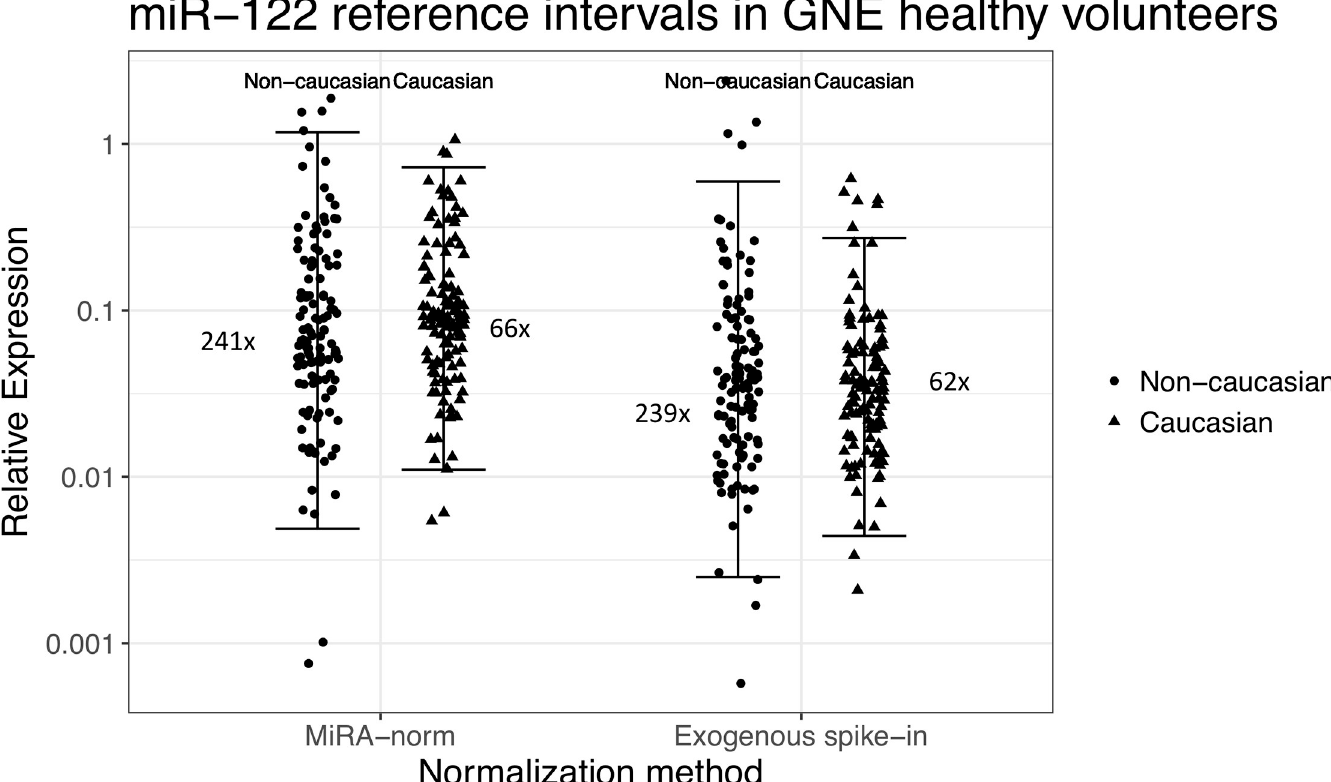
Fig 4. The 95% confidence reference ranges of miR-122 in serum from healthy volunteers separated by individually-identified ethnicity. The relative serum expression of miR-122 normalized to the mean expression of a panel of five endogenous miRNAs (“MiRA-norm”, left) or to the exogenous C eleg miR-39 exogenous spike-in (right) separated out by samples from volunteers that identified as Caucasian ( ▲ ) and those that did not (e.g. Non-Caucasian) ( ● ). Brackets represent the 95% confidence reference ranges for miR-122 serum expression normalized to miRNA-norm (left) or to C eleg miR-39 expression (right), where miR-122 relative expression spanned 239 to 241- and 62 to 66-fold when for Non-Caucasian and Caucasian ethnicity,